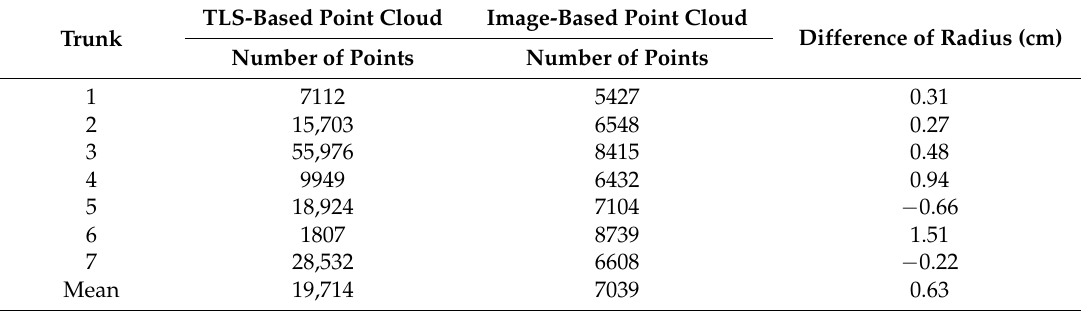
Table 4. Point density of each trunk section and differences in the radii estimated by cylinder fitting.